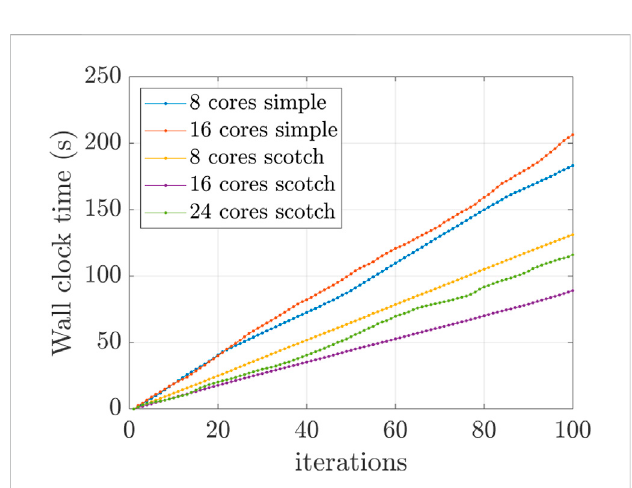
FIGURE 11 Domain decomposition strategies and their computation speeds. The “ Scotch method ” performs better than the “ Simple method.